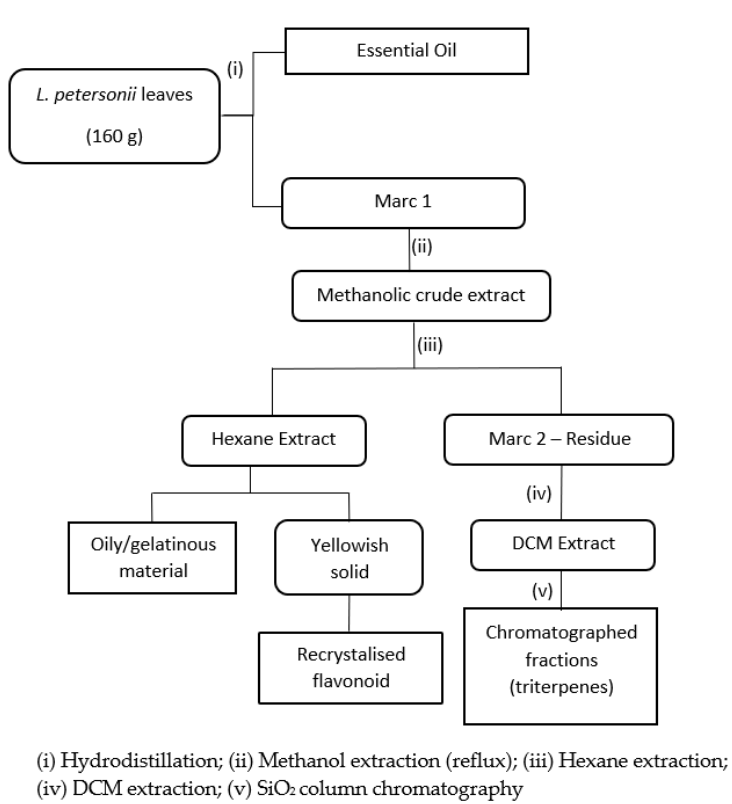
Figure 4. Extraction scheme for isolating natural products from Leptospermum petersonii leaves.